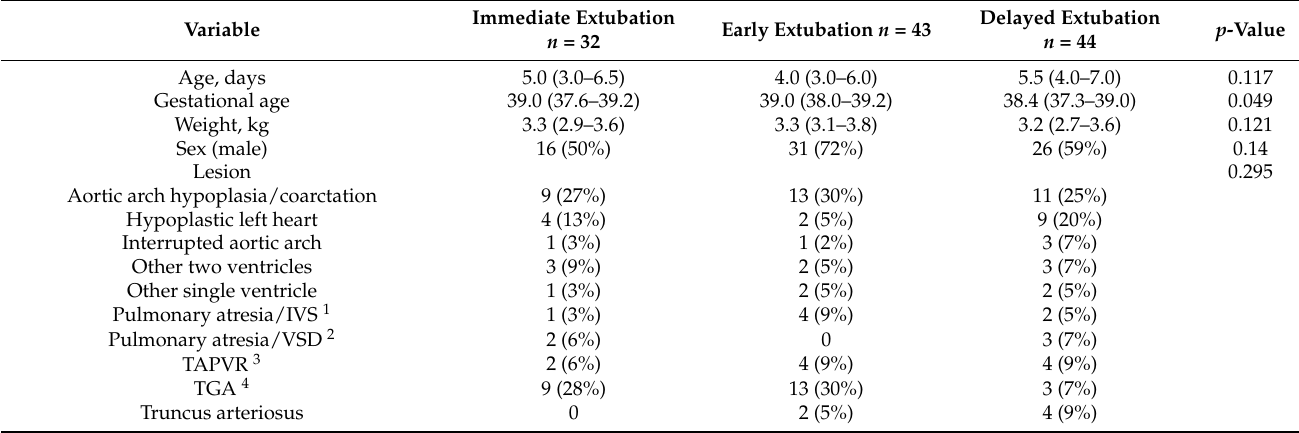
Table 1. Demographic and clinical characteristics based on timing of